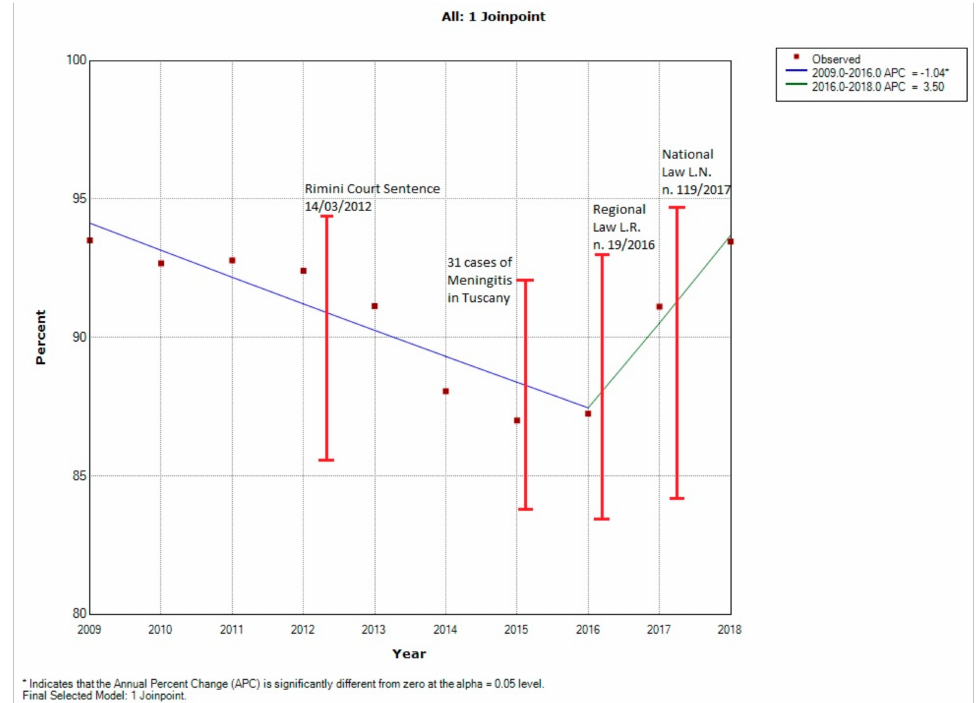
Figure 1. Trend of 24-month vaccination rates per 100,000 inhabitants between 2009 and 2018 in the Emilia-Romagna region.